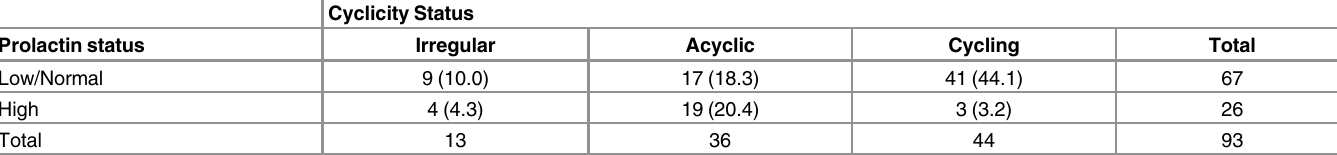
Table 4. Distribution/frequency (% of total) of Low/Normal ( < 18 ng/ml) and High ( (cid:1) 18 ng/ml) prolactin concentrations by cyclicity status for African elephants.